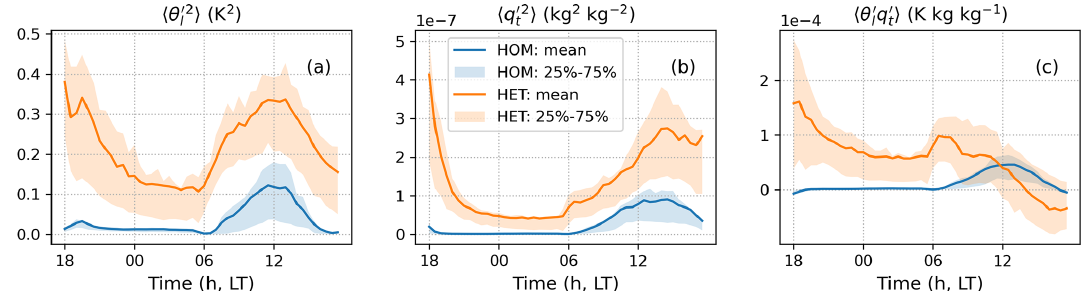
q (cid:48) t (cid:105) , which are prescribed based l